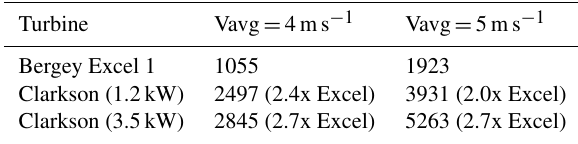
Table 2. AEP comparison of 2.5m rotors using standard Rayleigh distributions (kWh).